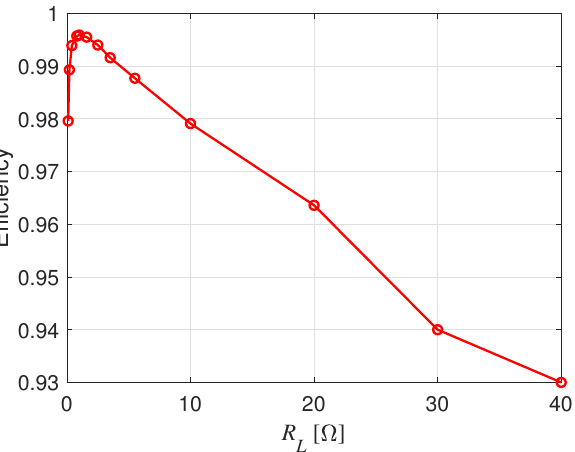
Figure 9. WPT efficiency varying the load resistance R L and assuming h = 10 cm, ρ = 0.5 cm. As a last test, the load voltage was computed considering four different load condi- tions: R L = [ 1, 10, 20, 40 ] Ω , when: h = 10 cm, ρ = 0.5 cm and L m = 6.18 µ H; the results are shown in Figure 10.